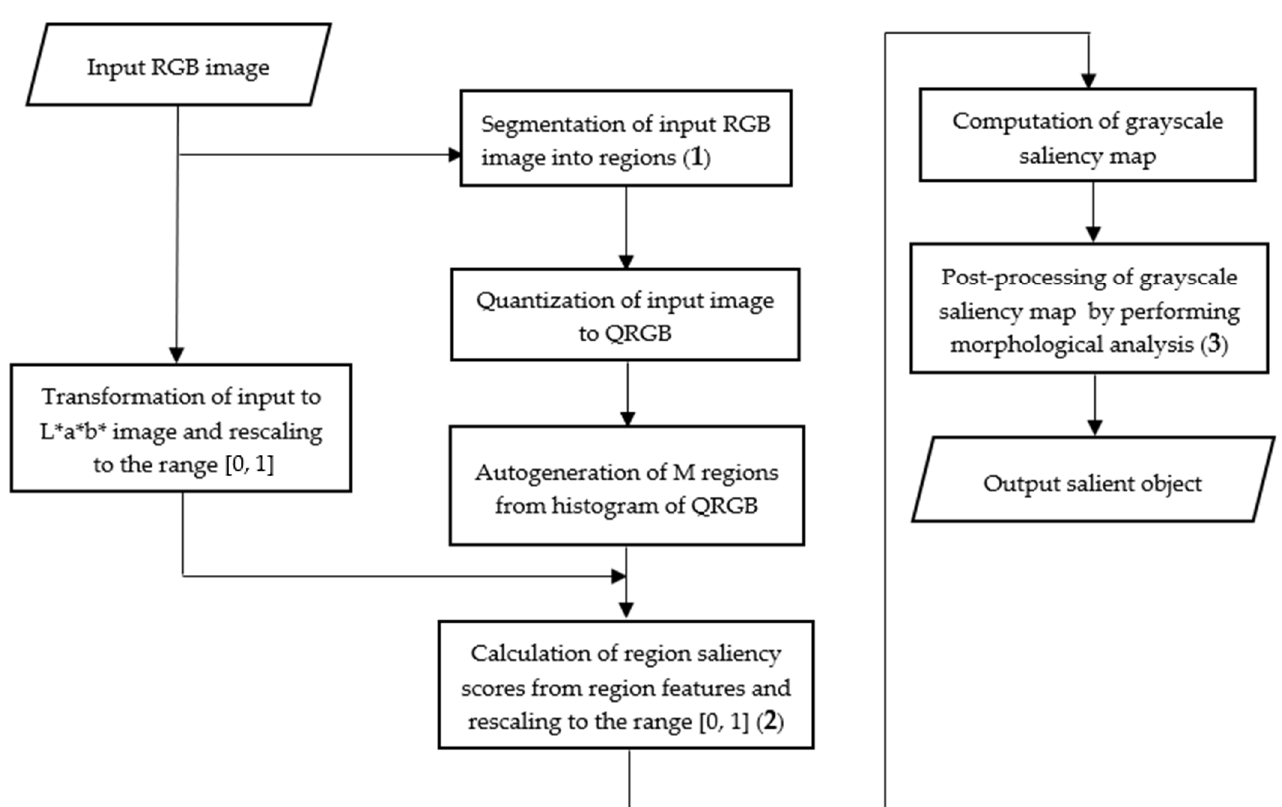
Figure 1. Flowchart of the color histogram clustering method for salient objects detection.